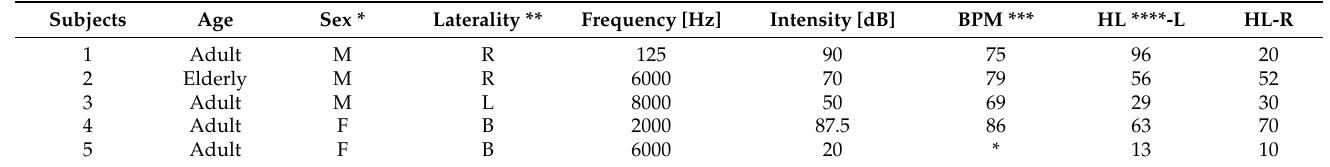
Table 4. Clinical and demographic characteristics of the study sample: Tinnitus